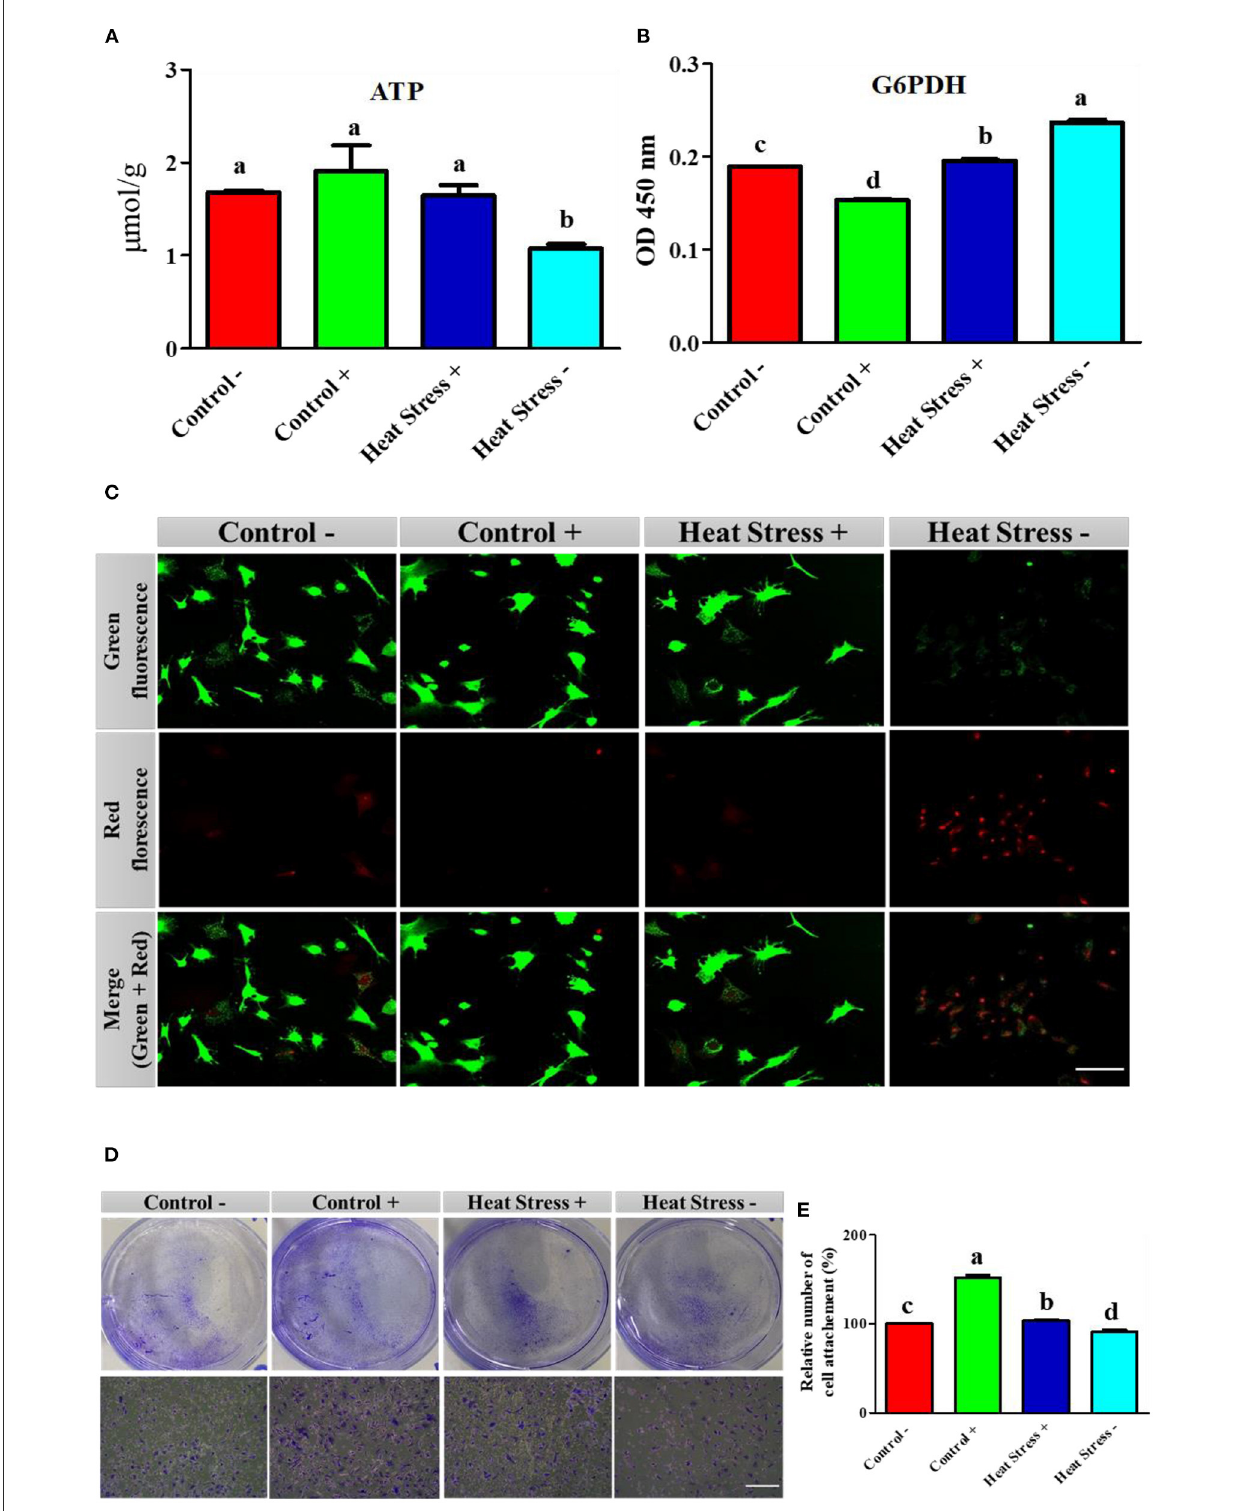
FIGURE3 Effects of COPA3 on stressed fibroblasts’ apoptosis through energy regulation. (A) Concentration of adenosine triphosphate (ATP); data represent mean ± SE; a,b different letters indicate significant difference in different groups ( P < 0.05). (B) Concentration of glucose 6 phosphate dehydrogenase (G6PDH); data represent mean ± SE; a,b different letters indicate significant difference in different groups ( P < 0.05). (C) Live and dead cell stain showing the live cells and apoptosed cells; scale bar = 50 µ m. (D) Crystal violet stain showing cell attachment; scale bar = 100 µ m. (E) Percentage of cell attachment; data represent mean ± SE; a,d different letters indicate significant difference in different groups ( P < 0.05). Groups are distinguished by temperatures and COPA3 treatment, that is, fibroblasts at 38 ◦ C (Control- group), 38 ◦ C with COPA3 treatment (Control + group), 43 ◦ C with COPA3 treatment (Heat Stress + group), and 43 ◦ C temperature (Heat Stress- group). Each experiment was conducted in four biological replicates ( n =